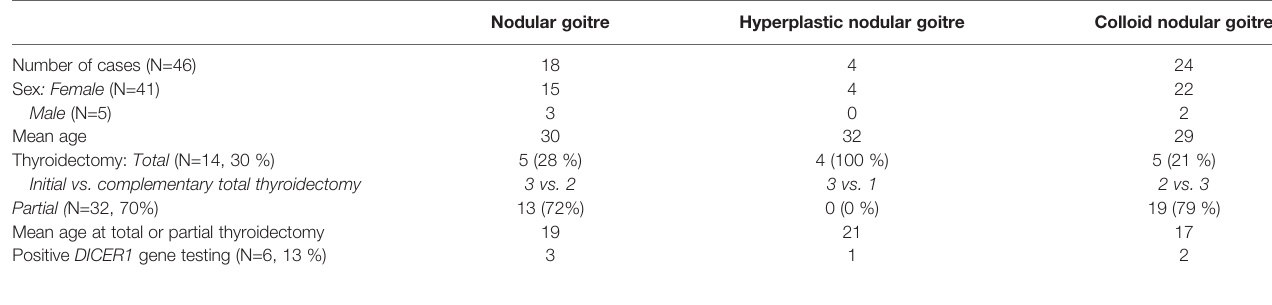
TABLE 1 | Baseline characteristics of the goitre cohort. Nodular goitre Hyperplastic nodular goitre Colloid nodular